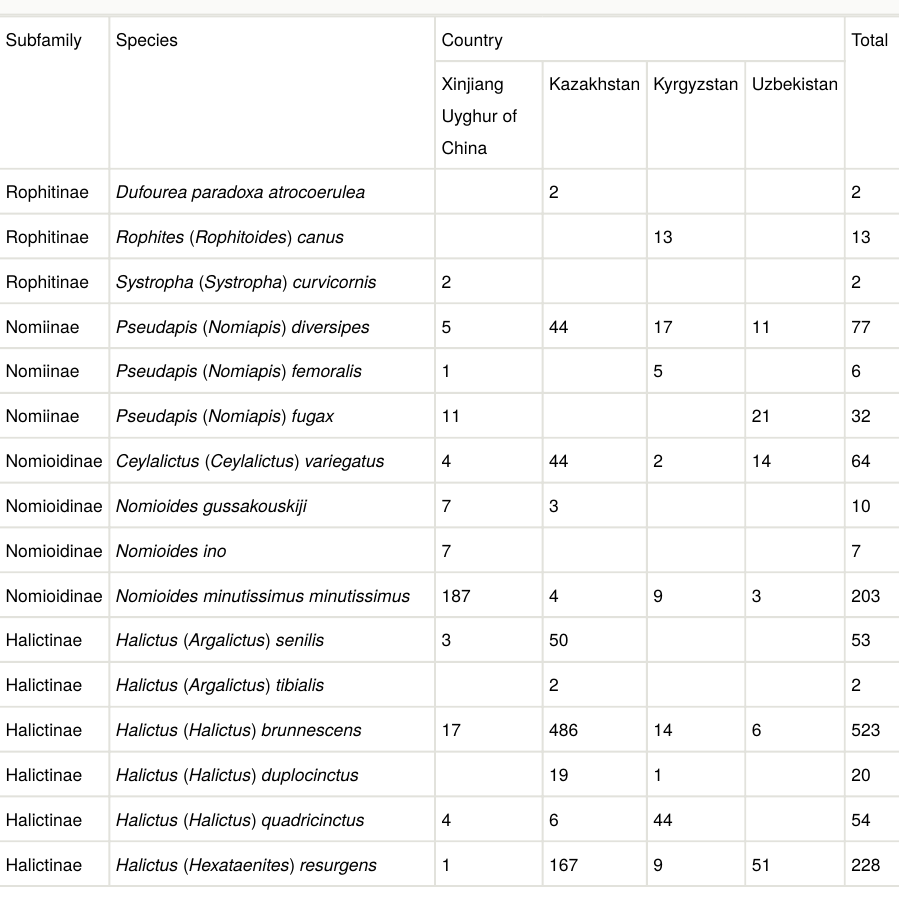
species (78 / 88 spp.) and individuals (15968 / 16384 exs.) (Table 1; Suppl. material 1). Particularly, the genus Lasioglossum was the most common group (50 / 88 spp.; 13220 / 16384 exs.). This genus is known to dominate both in the number of species and individuals in warm-temparate regions (Sakagami and Fukuda 1973; Maeta et al. 2003). This tendency is similar in our surveyed area of central Asia. Table 1. List of halictid bee species collected by Central Asian Expedition during 2000 to 2004 and 2012 to